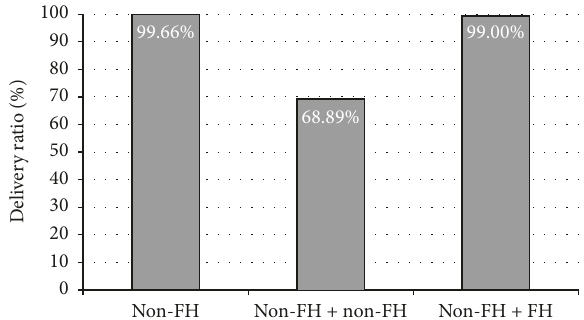
Figure 15: Average delivery ratio (non-FH vs. FH-129 systems).